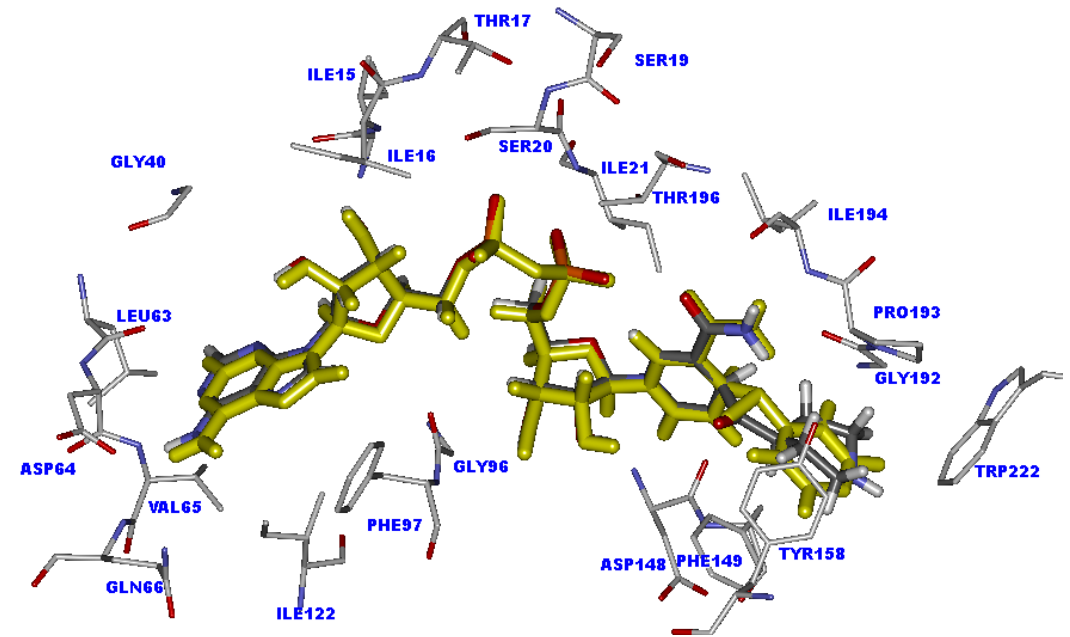
Figure 4. Superimposition of the INH-NAD adduct (colored by yellow) and compound 35 (colored by atom type) in the InhA binding pocket obtained from molecular docking